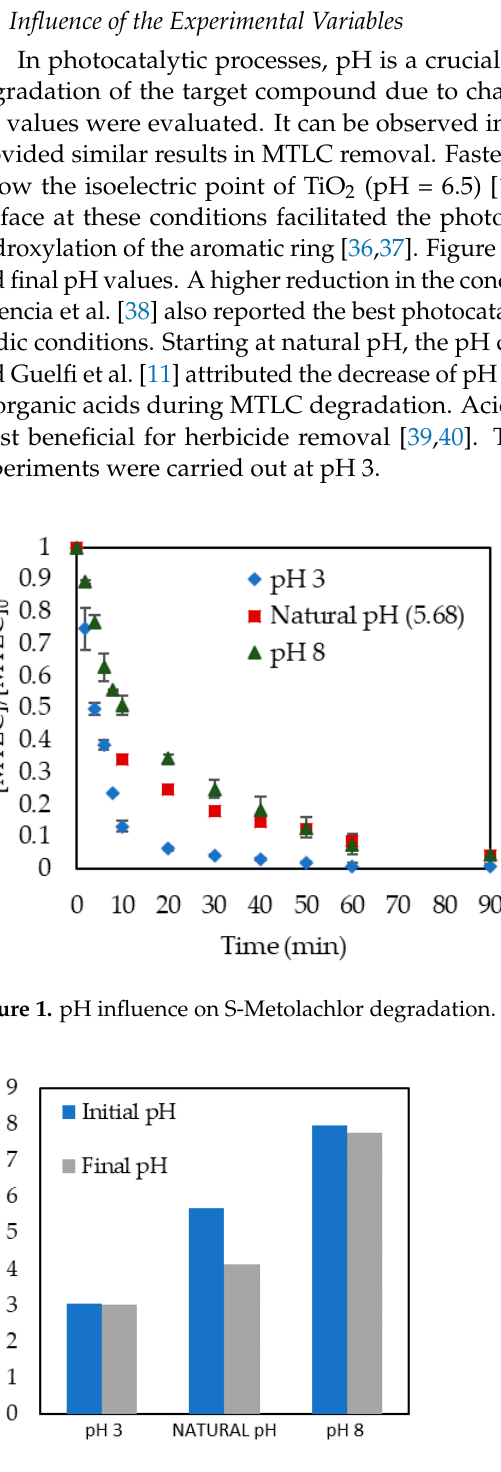
Figure 2. Comparison of initial and final pH after 480 min.